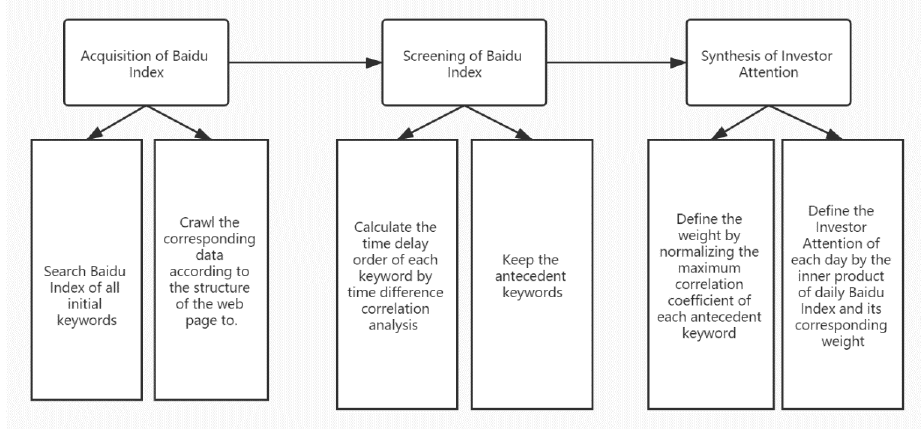
Figure 4. Flowchart for construction of investor attention factor.